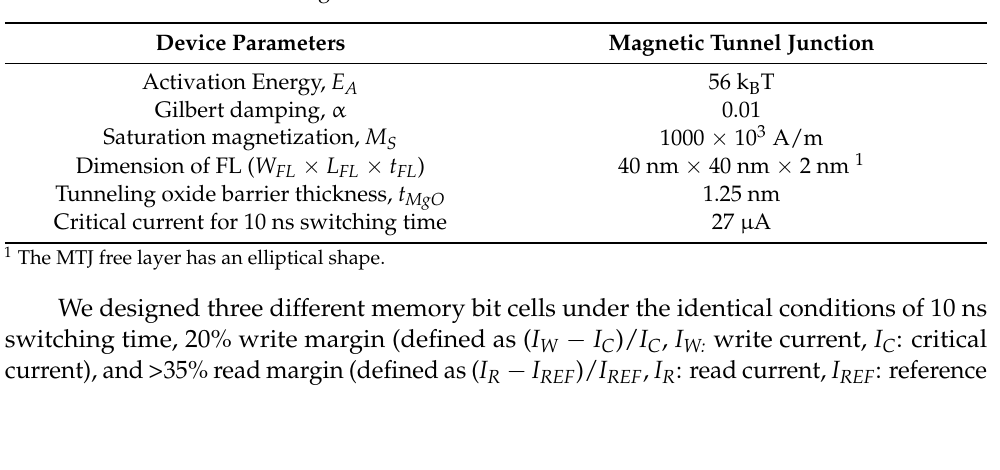
Table 1. Parameters of the storage